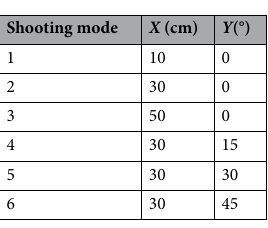
Table 1. Six shooting